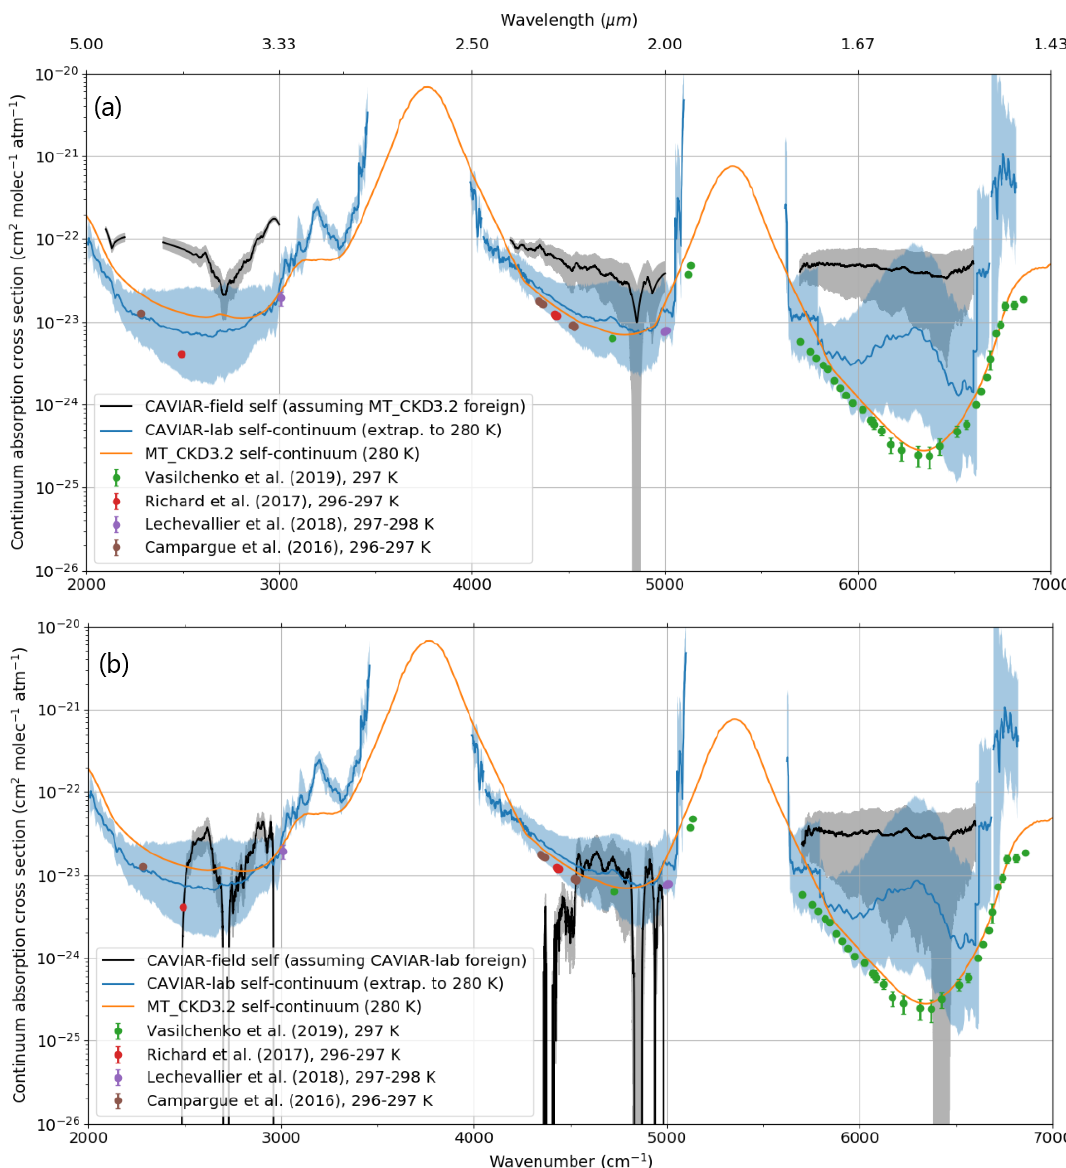
Figure 16. Self-continuum from CAVIAR-field as estimated using (a) the MT_CKD foreign continuum and (b) the CAVIAR-lab foreign continuum, alongside MT_CKD_3.2 and selected laboratory measurements. The grey shaded regions indicate the k = 1 confidence limits in the CAVIAR-field self-continuum and the blue shaded regions the uncertainty in the temperature-extrapolated (to 280K) CAVIAR-lab data. The darker shaded regions are where these uncertainty limits overlap. The CAVIAR-lab uncertainties are obtained via Monte Carlo fits using the uncertainties in the higher-temperature ( > 350K) CAVIAR-lab